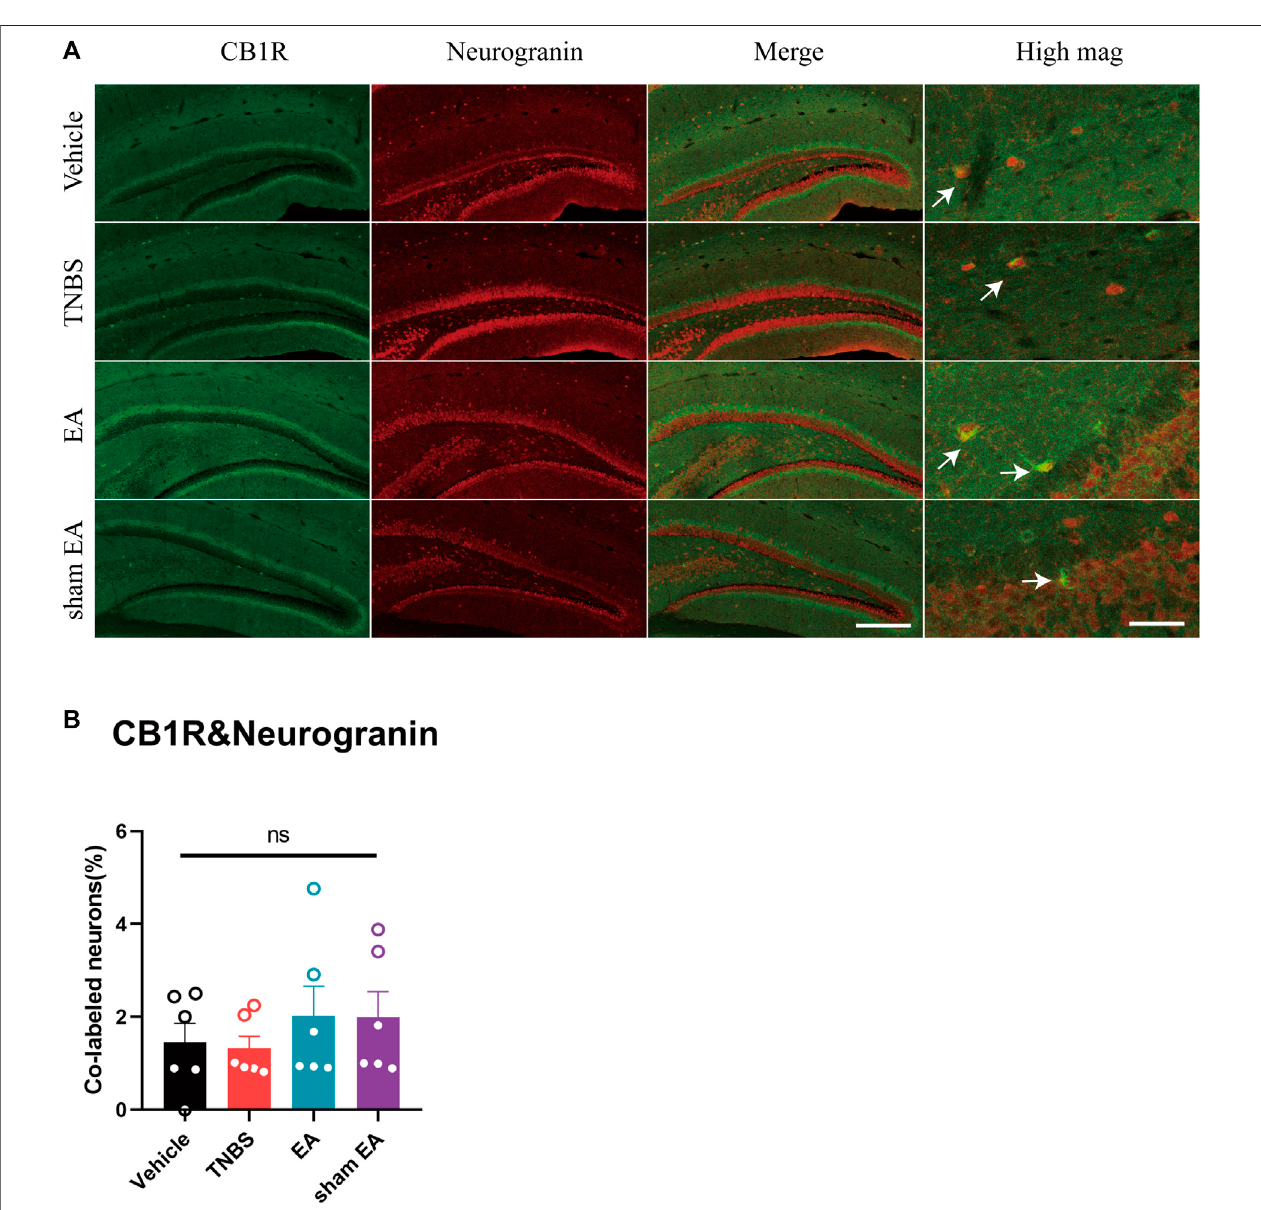
FIGURE 3 | TNBS and EA had no effect on the percentage of CB1R-expressed glutamatergic neurons in the vHPC of IBD mice. (A) Immuno fl uorescence images showed CB1R (green) co-expressed with neurogranin (a marker of glutamatergic neurons, red) in the vHPC. (B) Percentage of CB1R-expressed neurons co-labeled with neurogranin, which is (CB1R and neurogranin co-labeled neurons /total neurogranin neurons) *100%. Scale bar for merge images, 100 μ m. Scale bar for high magni fi cation images (high mag), 20 μ m. Ns represents p > 0.05 between marked groups.